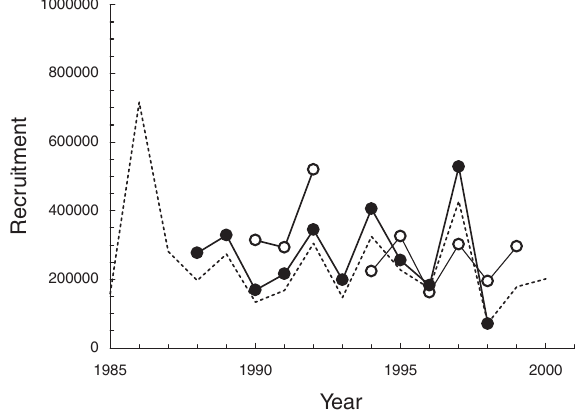
F IG . 3. – Time series of recruitment of North Sea cod reconstructed from the most recent VPA (dotted line) and time series of recruit- ment indices derived from the International Young Fish Surveys (IYFS) for 0-group (plain line, open circles) and 1-group (plain line, closed